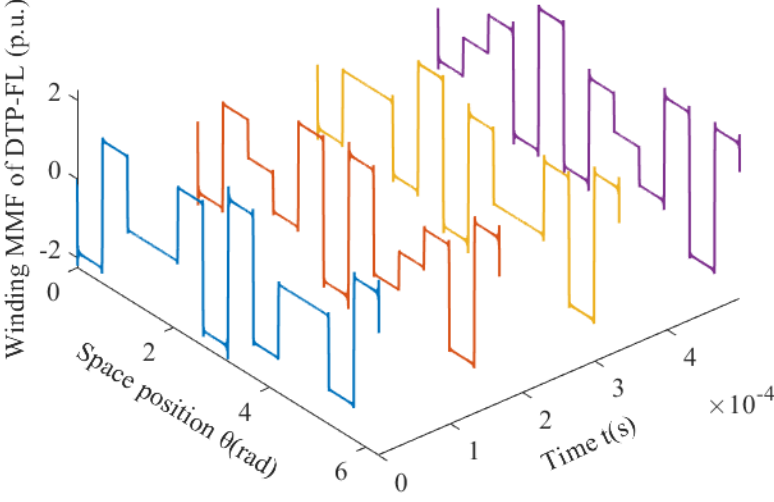
Figure 13. Resultant winding MMF of 12-slot/10-pole DTP-FL winding at time t = 0 s. ( a ) First group of TP winding, ( b ) second group of TP winding, ( c ) two groups of TP winding. Similarly, for a 12-slot/10-pole DTP-FL winding, resultant winding MMFs F ( θ , t ) are given by WFM as shown in Figure 14.